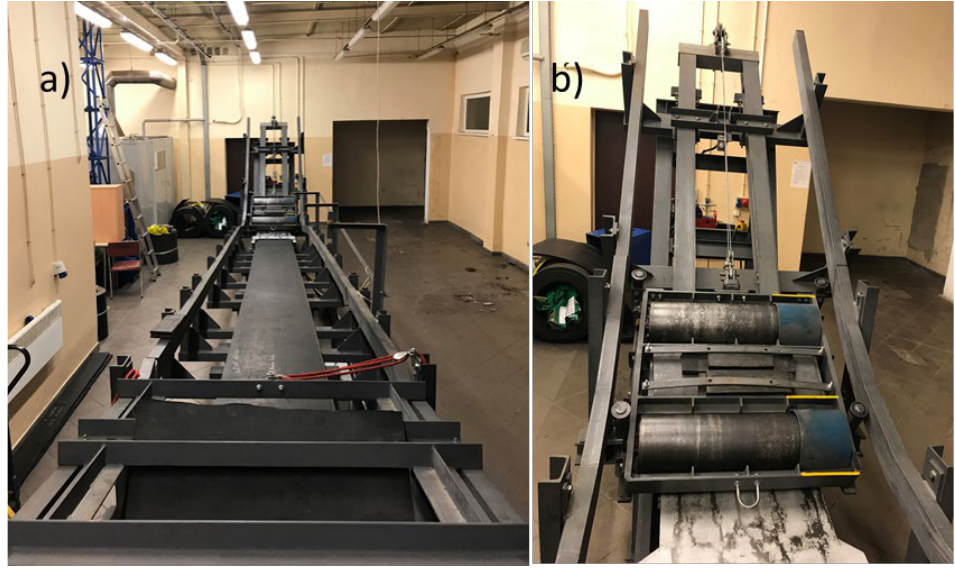
Figure 3. The test rig ( a ) and the loading carriage ( b ).